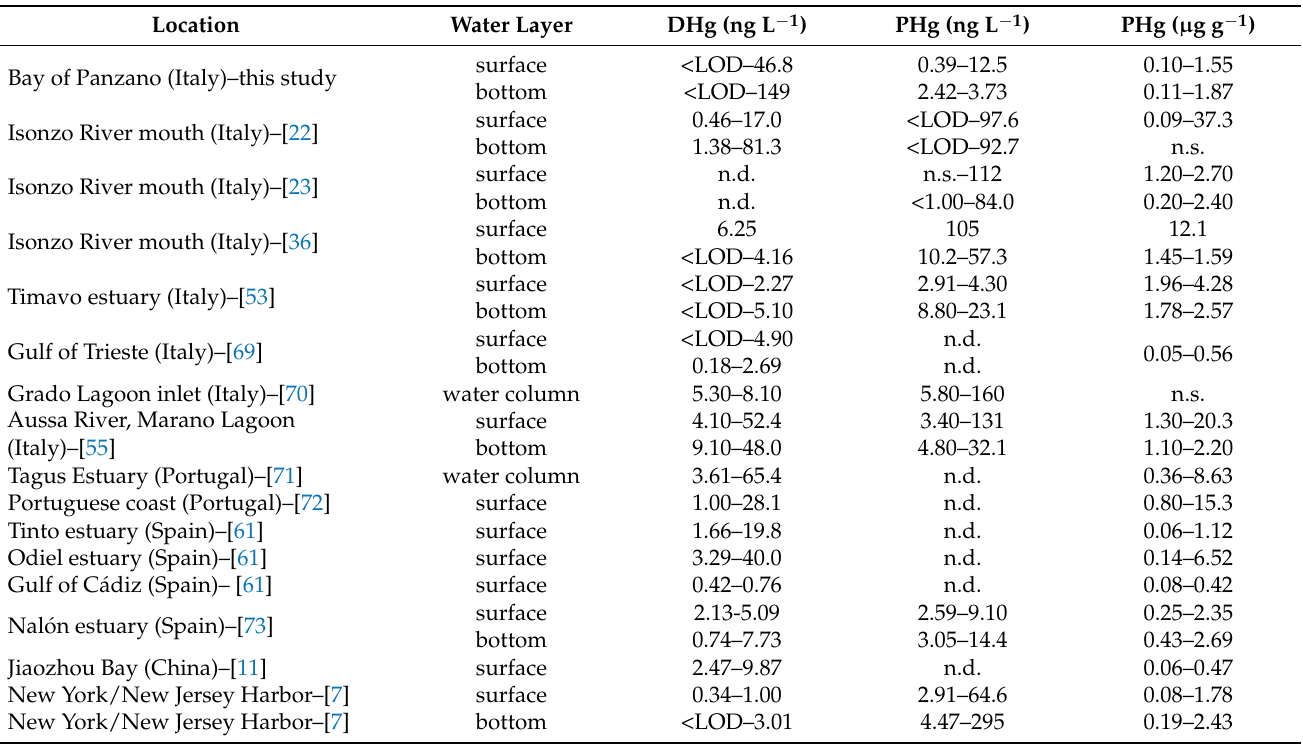
Table 3. Ranges of Hg concentration in the dissolved fraction (DHg, ng L − 1 ) and in the SPM (PHg, µ g g − 1 and ng L − 1 ) from this study compared to local areas of the Gulf of Trieste and other similar environments as reported in the